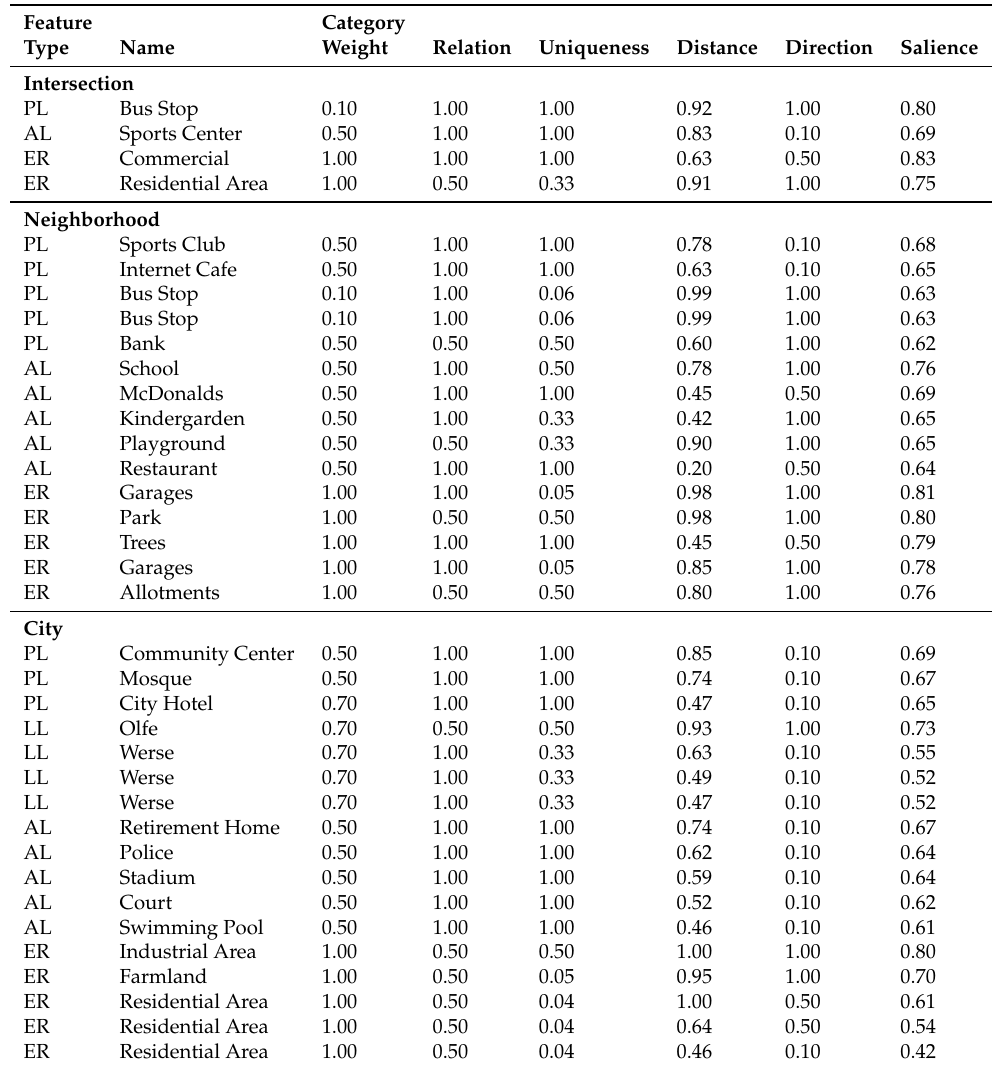
Table 7: Numerical results of case